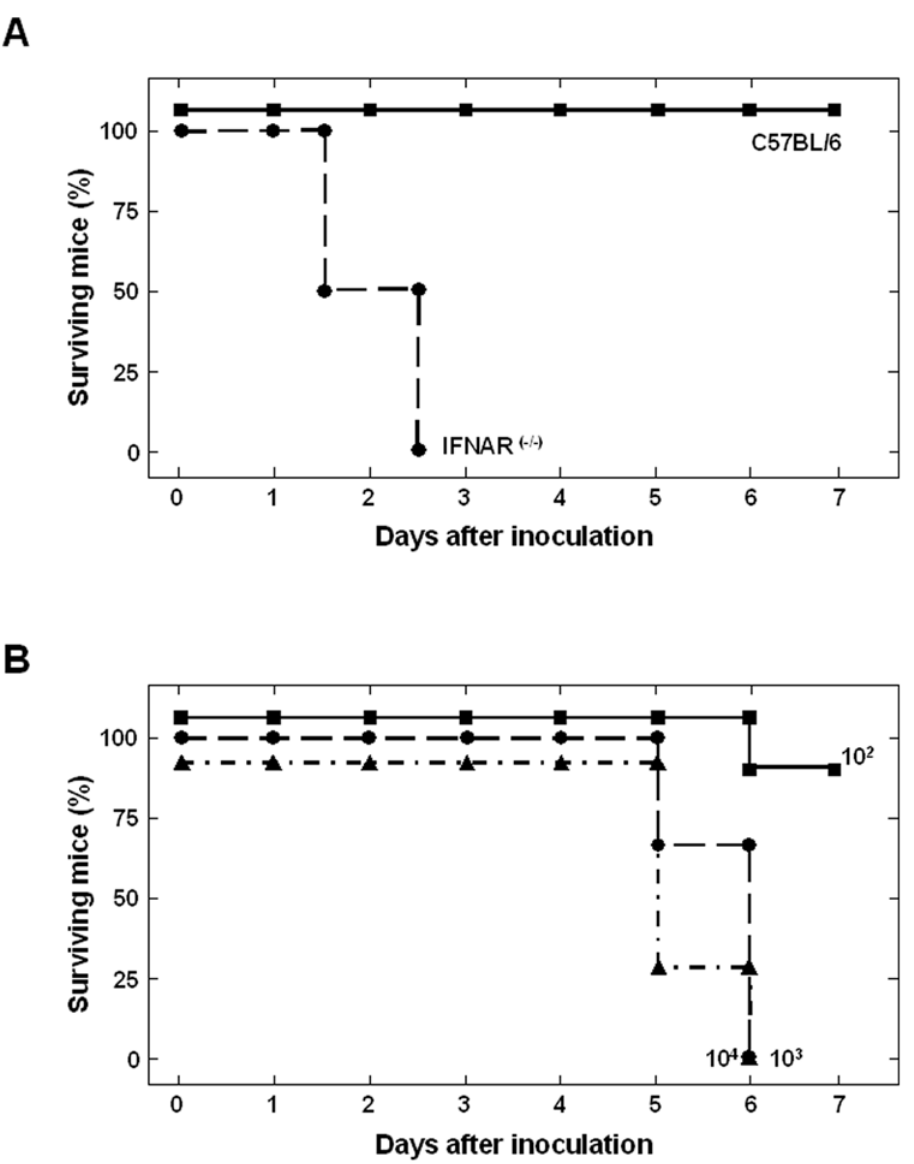
Figure 1. Susceptibility of adult mice to BTV-4 infection. (A) C57BL/6 and IFNAR ( 2 / 2 ) mice (8 weeks old, 6 mice per group) were intravenously inoculated with 10 6 PFUs of BTV-4. The mice were observed every 12 h for the first 3 days and every 24 h for 7 days. (B) Survival rates of IFNAR ( 2 / 2 ) mice after inoculation with BTV-4. Mice (8 weeks old, 6 mice per group) were intravenously inoculated with 10-fold dilutions of BTV-4. The number of PFUs inoculated is indicated on each survival group. The mice were observed every 24 h for 7